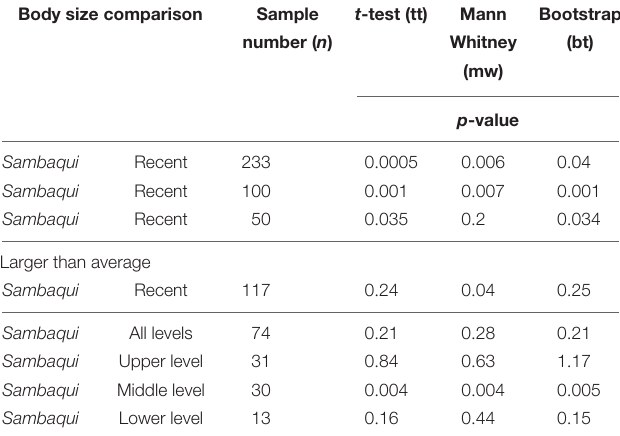
TABLE 1 | Statistical pairwise values between the body size of ancient and recent valves. Body size